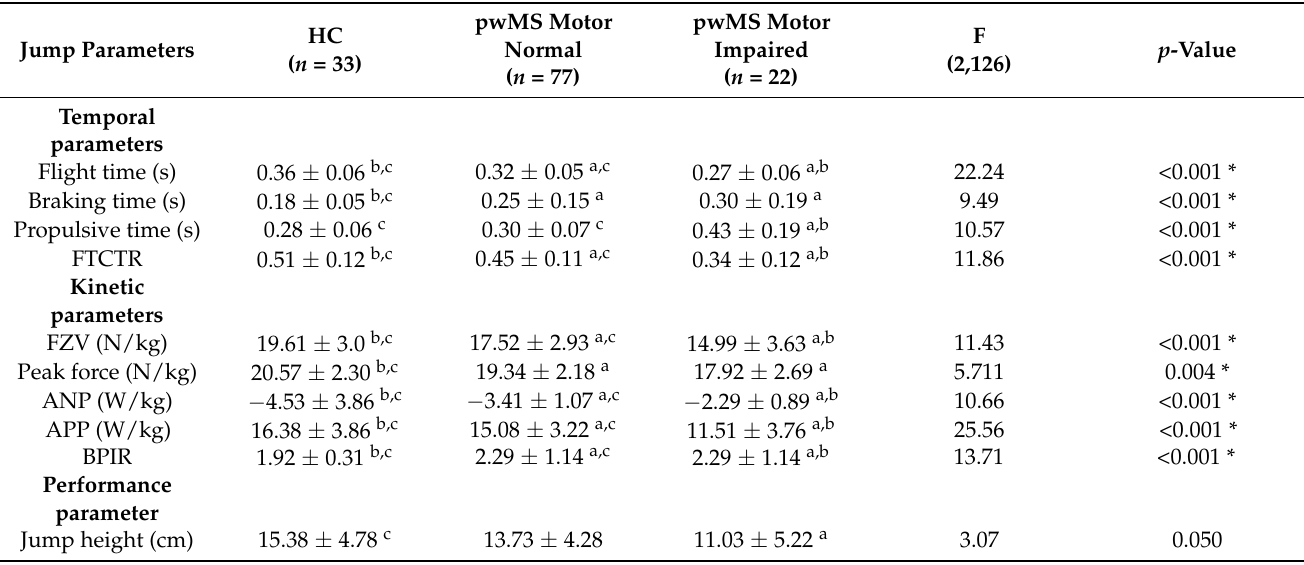
Table 3. Jump parameters in pwMS and